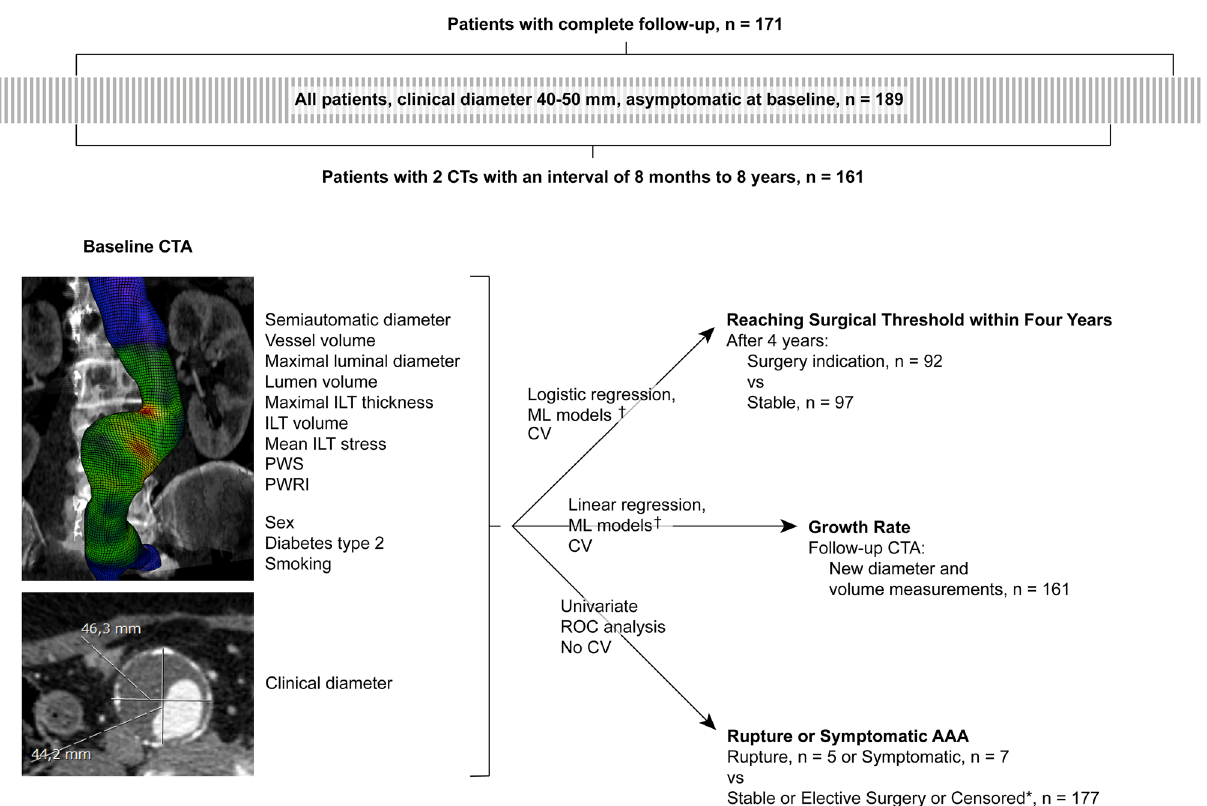
Figure 1. Overview of study design. Abbreviations ; CTA: computed tomography angiography, CV: cross- validation, ILT: intraluminal thrombus, ML: machine learning, PWRI: peak wall rupture index, PWS: peak wall stress, ROC: receiver operating characteristic. *: Patients were censored if they died from unrelated causes or follow-up was terminated before surgery. †: Included prediction models were ridge regression, least absolute shrinkage and selection operator, k-nearest neighbors, support vector machines with linear and polynomial kernels, random forest, gradient boosting machines and artificial neural